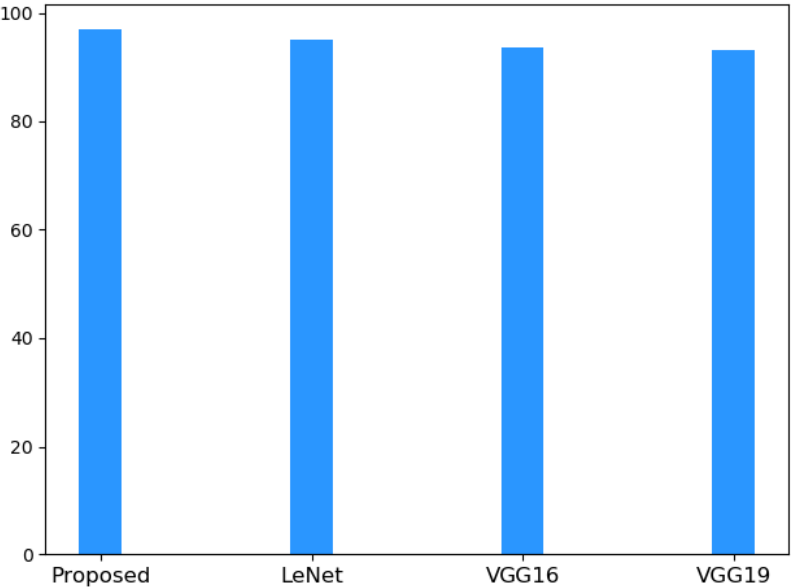
Figure 12. Comparison of the proposed approach with the LeNet [52], VGG16 [53], and VGG19 [54]. Y -axis shows the F-measure.